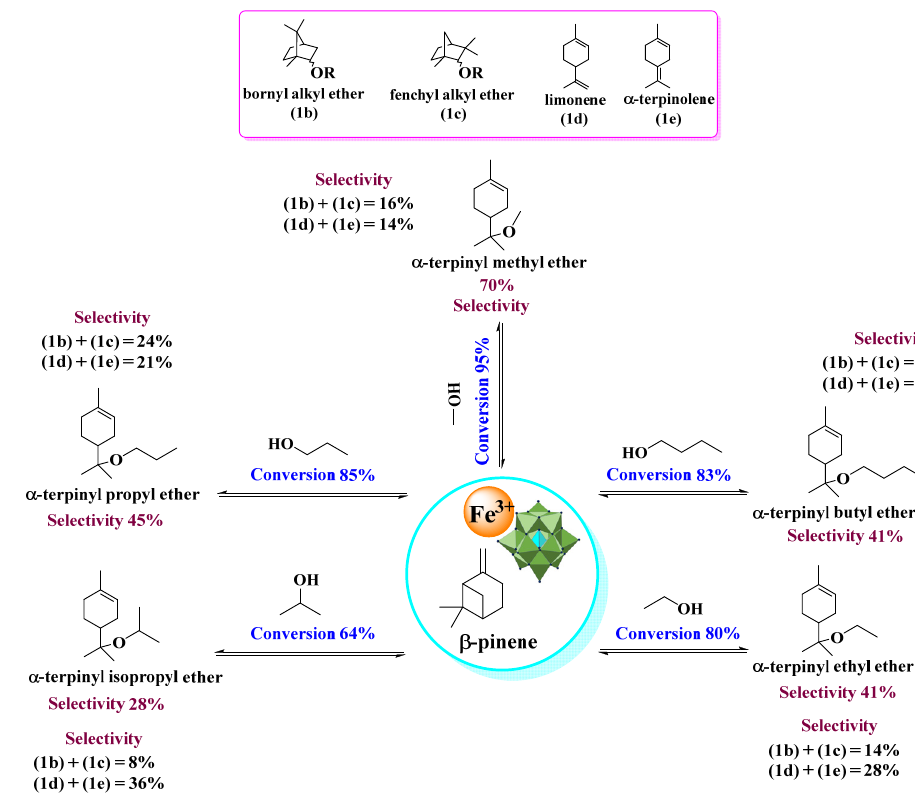
Figure 11. Impacts of metal cation on the conversion and selectivity of phosphotungstate-catalyzed reaction of β -pinene with methyl alcohol (adapted from ref. [34]) a . a Reaction conditions: β -pinene (3.8 mmol), CH 3 OH (14.3 mL), temperature (333 K), catalyst (0.50 mol%), volume (10 mL). The impact of the size of the carbon chain was also evaluated in reactions with C1-C4 alcohols and β -pinene (Scheme 8)